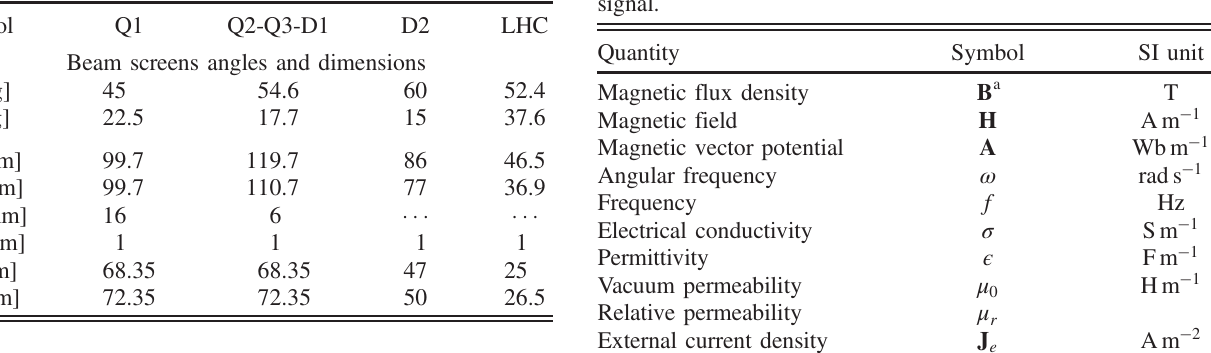
TABLE II. Physical quantities of the constitutive equations governing the beam screen behavior subject to a time-harmonic